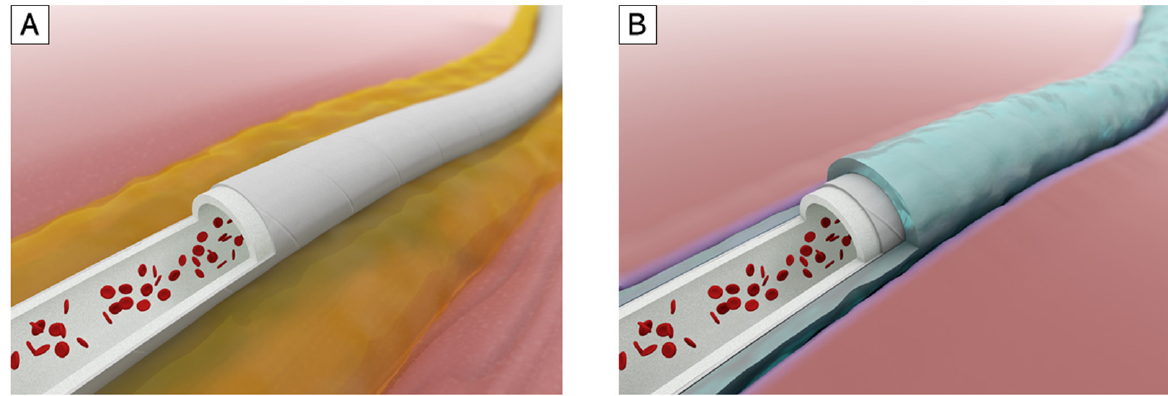
Figure 1. ( A ) Poor perigraft tissue incorporation can cause seroma, an abnormal fluid correction around the implanted vascular graft. Massive seroma may lead to graft infection; ( B ) A vascular graft coated with radiation-crosslinked gelatin hydrogel, a material that promotes wound healing process. We hypothesized that this coating technology may facilitate perigraft tissue incorpora- tion.